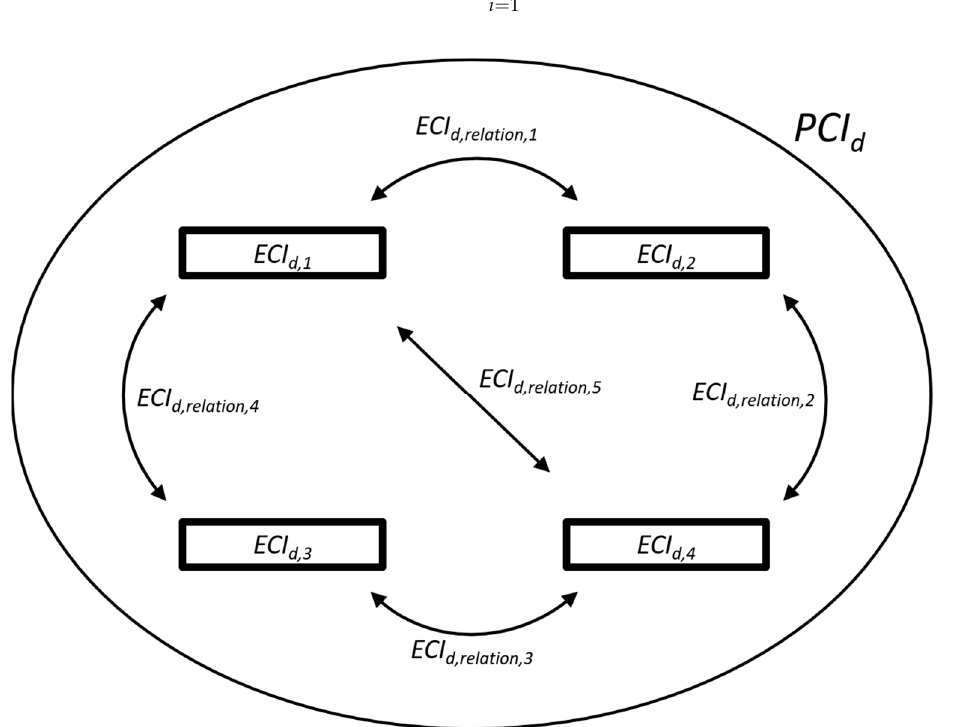
Figure 3. Visualisation of the relation between the element level and the product level. In this example, there are four elements ECI d that are connected to each other, defined in ECI d,relation , and together they form the product PCI d .